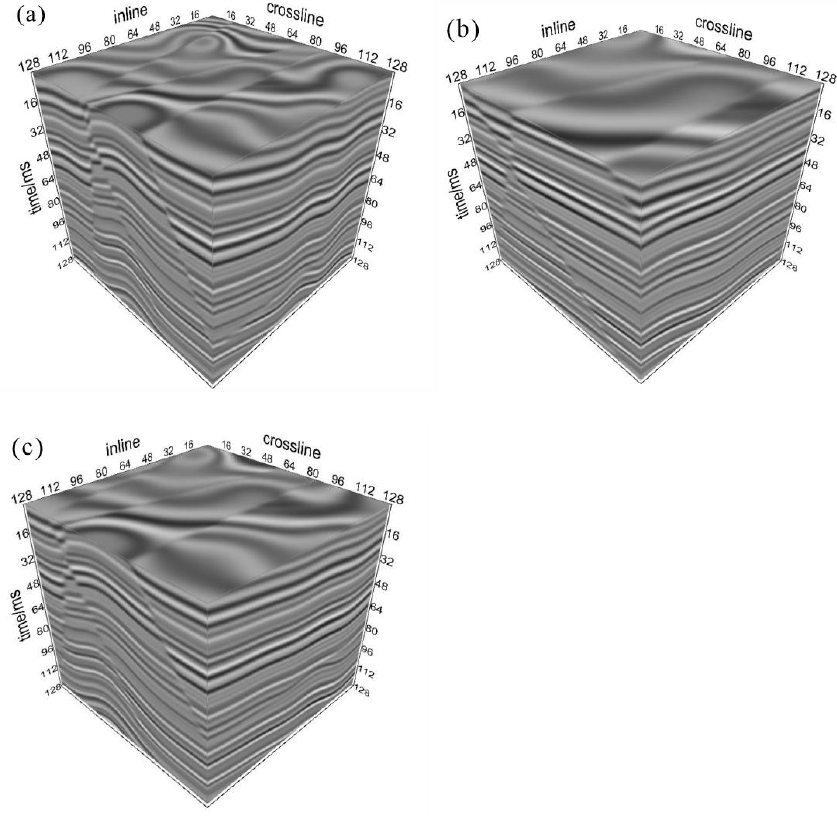
Figure 5. Data random clipping processing. ( a ) Simulated seismic data; ( b ) crop to 64 × 64 and padding; ( c ) crop to 96 × 96 and padding.